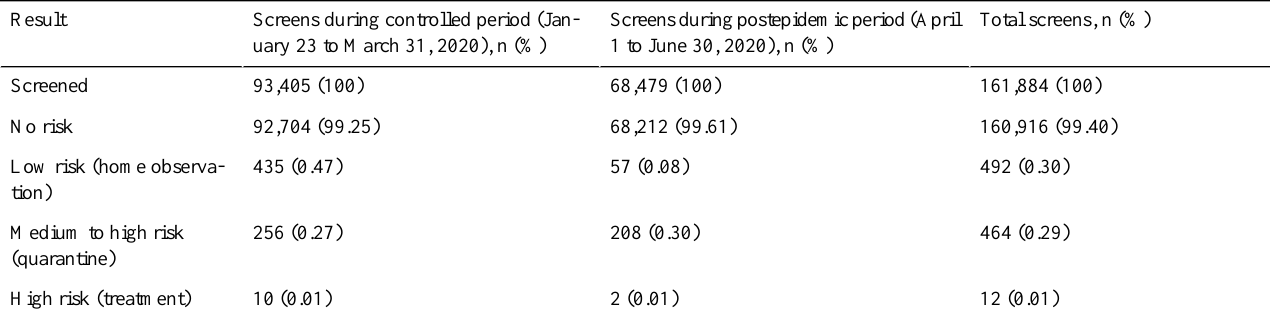
Table 2. Results of automated COVID-19 screening during the controlled period and postepidemic period (N=161,884).